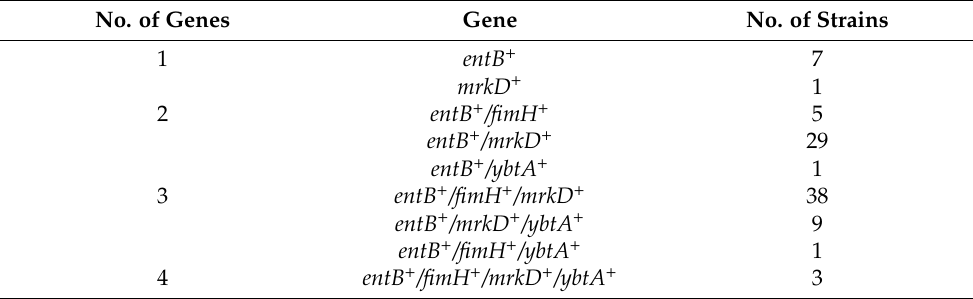
Table 2. The virulence-related gene profiles in the 94 K. pneumoniae strains. No. of Genes Gene